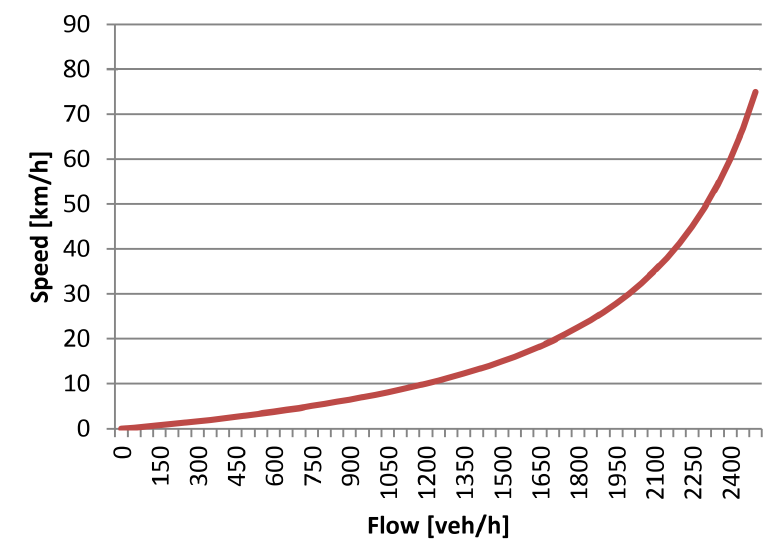
Figure 4. An uncongested road section’s speed-flow curve. The flow (veh/h) of the road segment grows when the speed (km/h) increases, as long as all vehicles can travel at free-flow speed. This is a fundamental diagram of traffic flow that is widely acknowledged in the literature